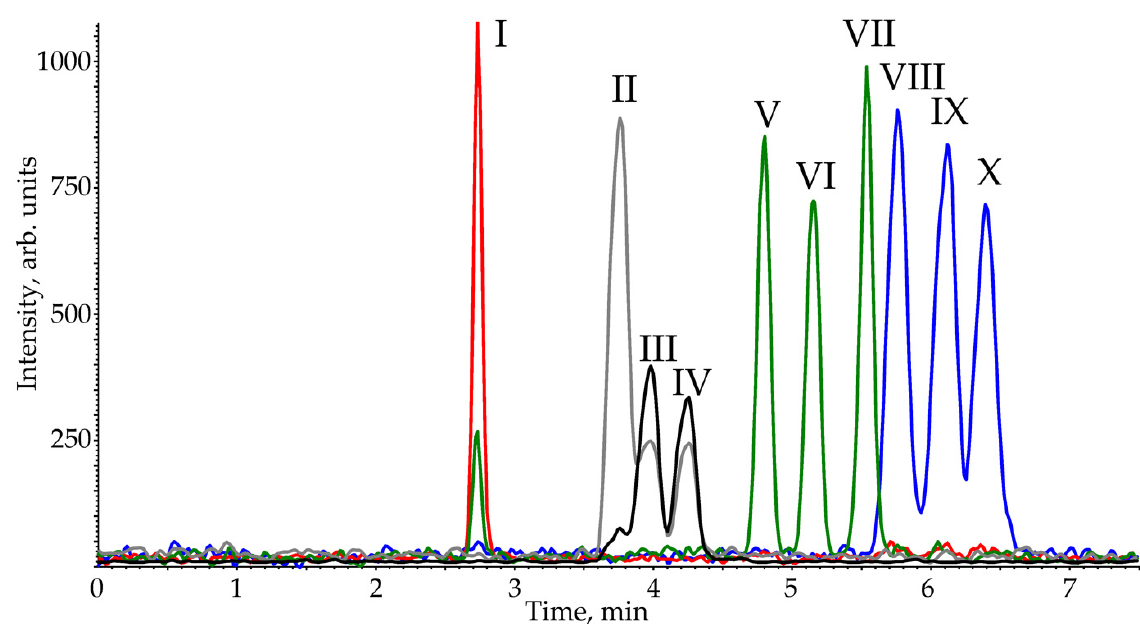
Figure 3. SFC-APCI-MS/MS chromatogram of analytes model mixture (I—200 µ g · L –1 ; II, VIII and Figure 3. SFC ‐ APCI ‐ MS/MS chromatogram of analytes model mixture (I—200 μ g ∙ L –1 ; II, VIII and X—100 µ g · L –1 ; III, IV and IX—50 µ g · L –1 ; V, VI and VII—25 µ g · L –1 ) obtained on HSS C18 SB stationary X—100 μ g ∙ L –1 ; III, IV and IX—50 μ g ∙ L –1 ; V, VI and VII—25 μ g ∙ L –1 ) obtained on HSS C18 SB stationary phase in the optimized conditions. phase in the optimized conditions.